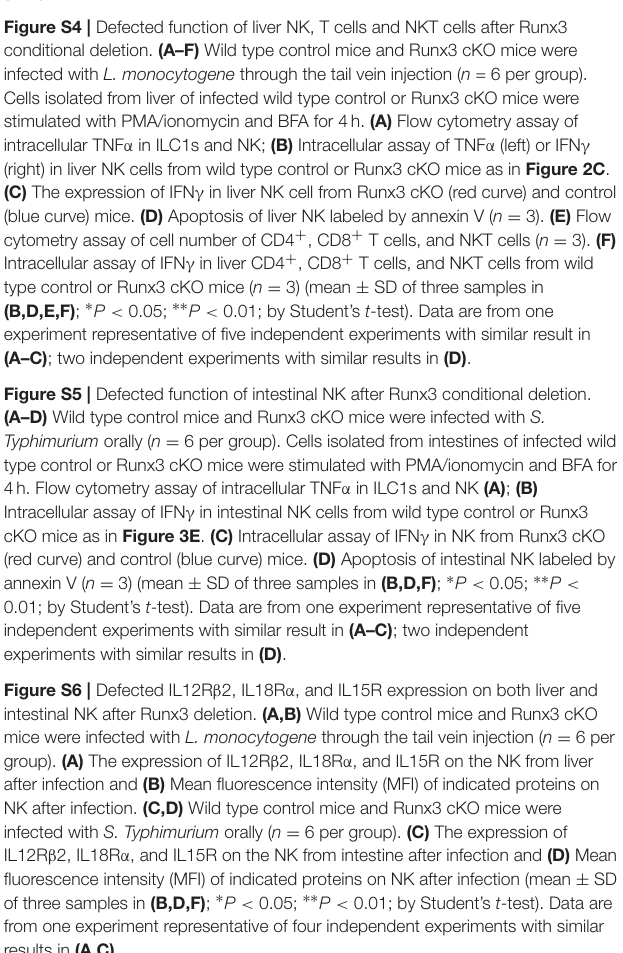
Runx3-cKO (red curve) and control mice (blue curve) (mean ± SD of three